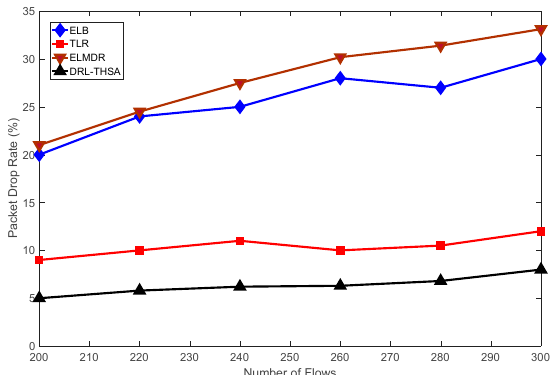
Figure 7. The packet drop rate with different number of flows.